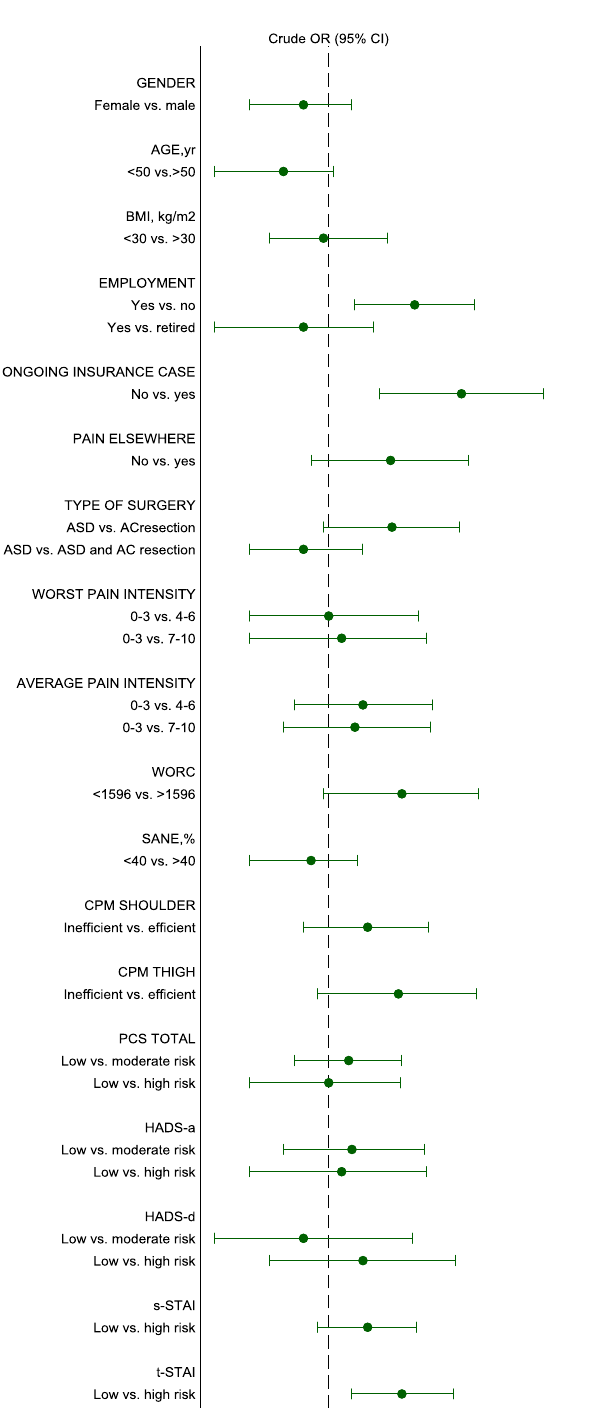
Figure 2. Preoperative risk factors for unexplained persistent pain (univariable).